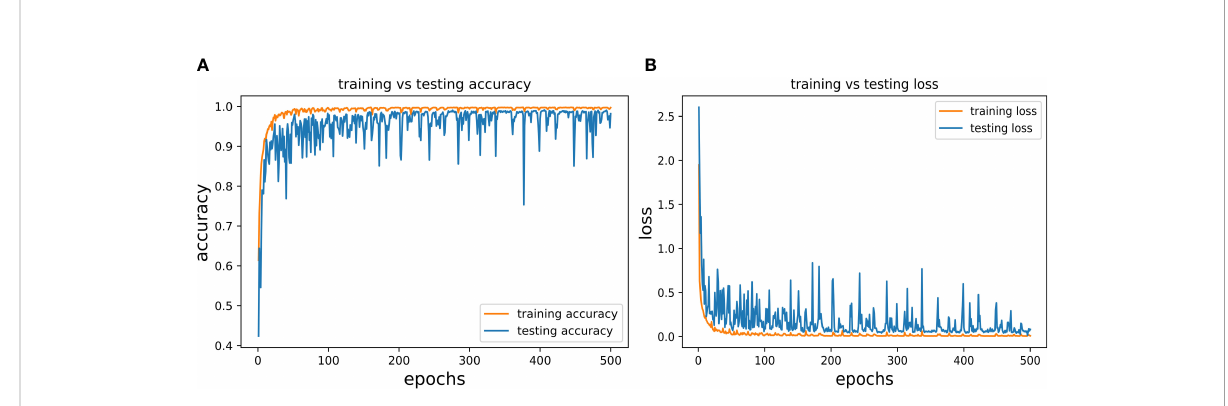
FIGURE 6 Epoch-wise behaviour of training and testing of the proposed CNN model (A) Classi fi cation accuracy: training vs testing and (B) Loss: training vs testing.